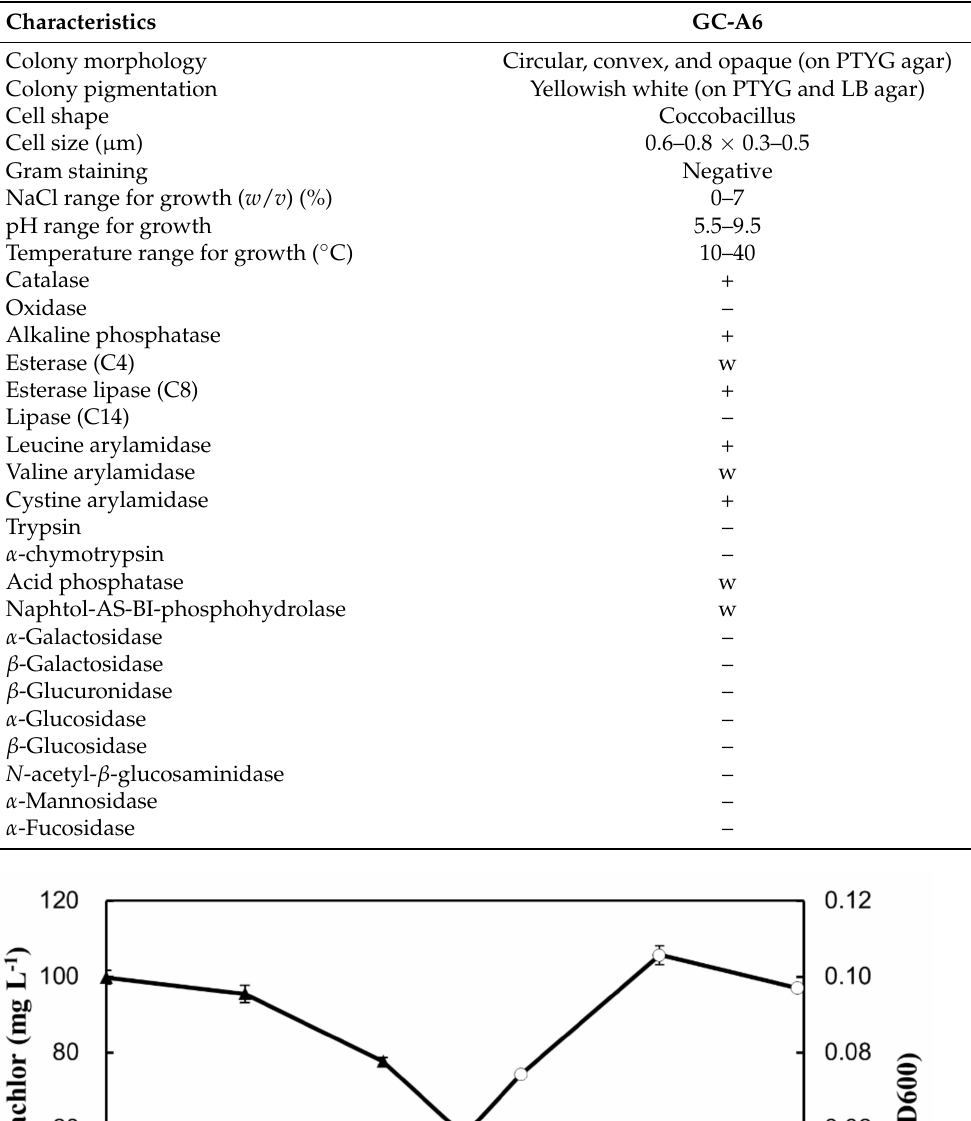
Table 1. Morphological, physiological, and biochemical characteristics of the alachlor-degrading bacterial strain GC-A6.